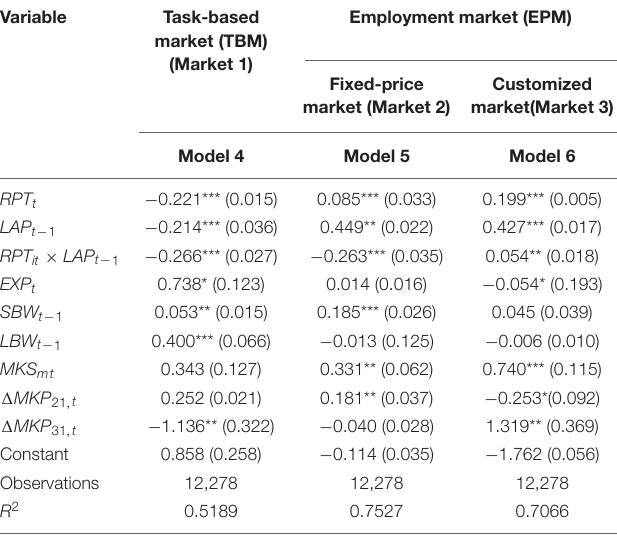
TABLE 4 | Panel fixed-effects regression analysis results of vendors’ market participation rate.